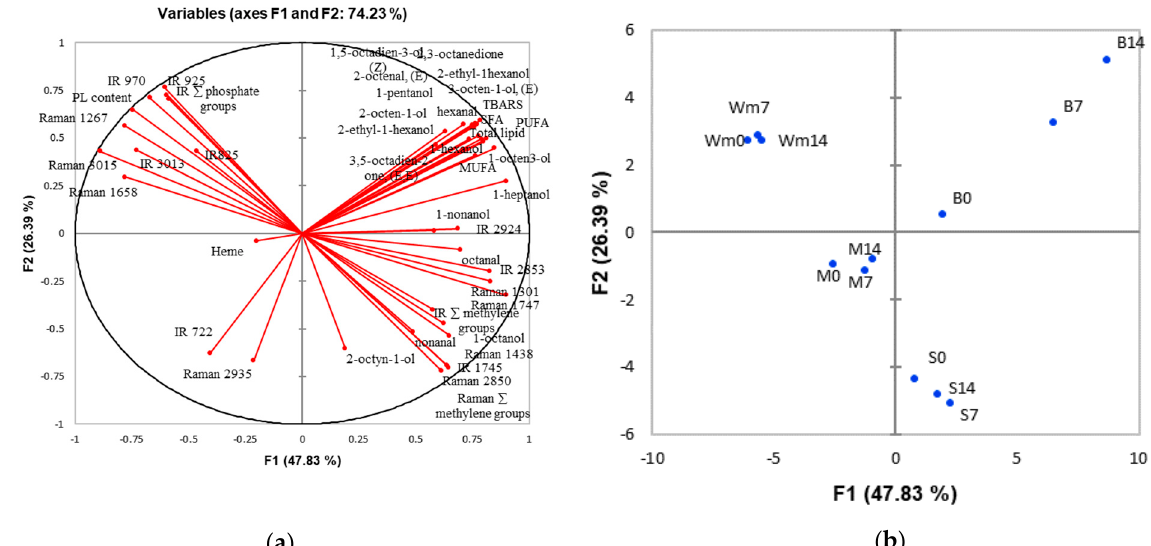
Figure 1. Correlation loading plot ( a ) and score plot ( b ) of principal component analysis describing measured quality parameters, namely volatile compounds, fatty acid profiles, lipid oxidation indicators and band intensity obtained from FT-IR and FT-Raman spectroscopy of skin (S), belly flap (B), and mince (M) of silver carp stored in ice for various times 0, 7 and 14 days and washed mince (Wm) prepared from fish stored in ice for 0, 7, and 14 days .